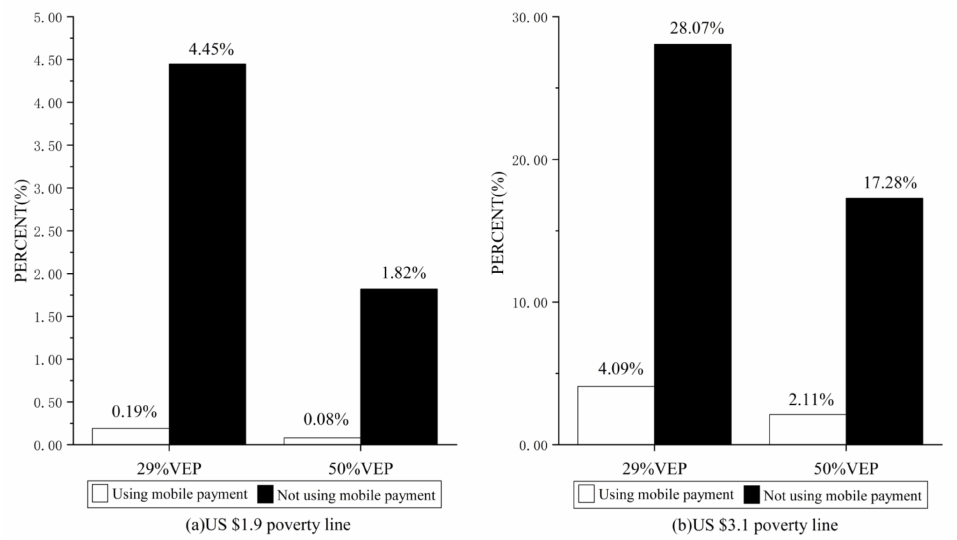
Figure 2. Descriptive statistics for different subgroups of household poverty vulnerability.